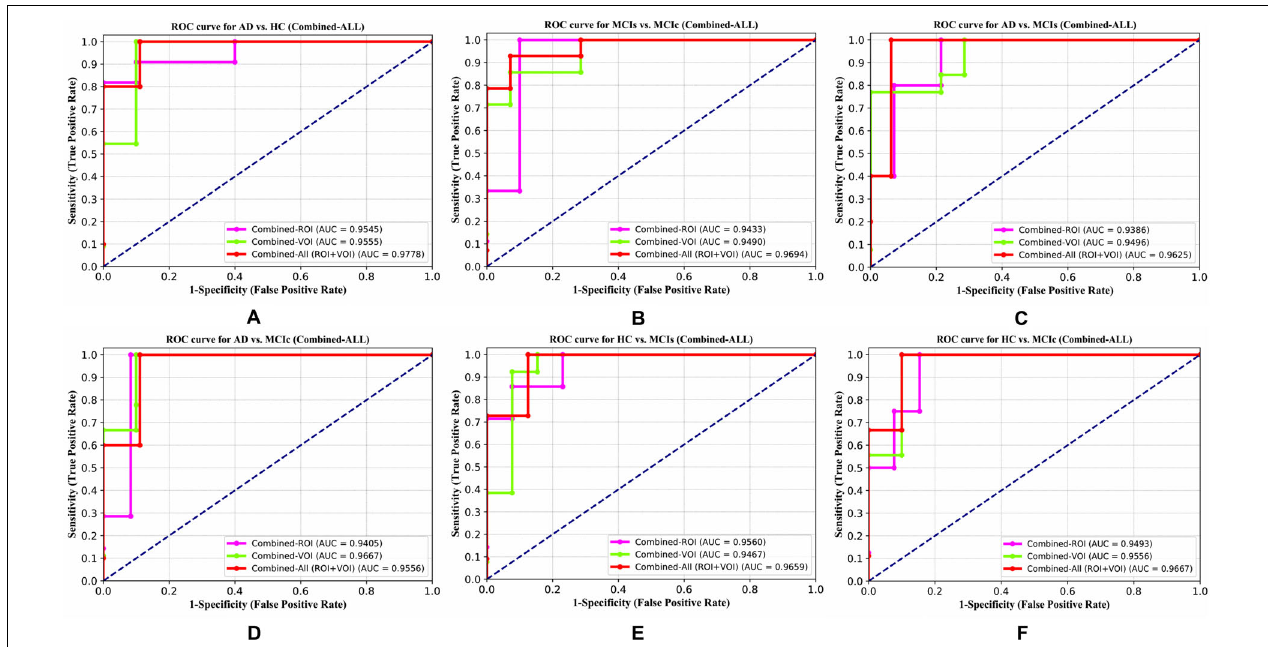
FIGURE 10 | ROC curve for (A) AD vs. HC, (B) MCIs vs. MCIc, (C) AD vs, MCIs, (D) AD vs, MCIc, (E) HC vs. MCIs, and (F) HC vs. MCIc using combined-(VOI + ROI). The red solid line shows the result of the combined-(VOI + ROI) curve, with combined-ROI and combined-VOI features.